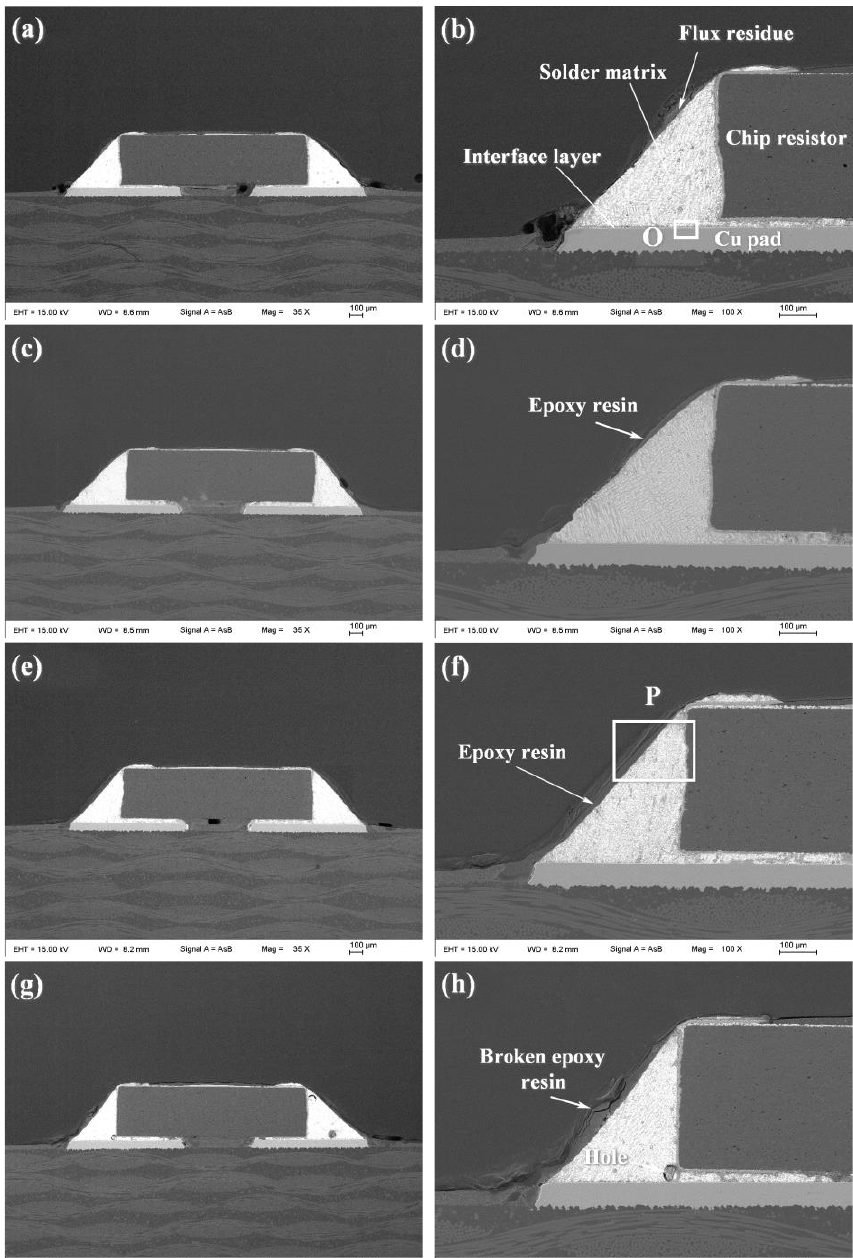
Figure 6. Cross-section SEM images of plain SAC305 and SAC305-ER solder joints: ( a , b ) plain SAC305, ( c , d ) x = 4 wt %, ( e , f ) x = 8 wt %, ( g , h ) x = 12 wt %. SAC305, ( c , d ) x = 4 wt%, ( e , f ) x = 8 wt%, ( g , h ) x = 12